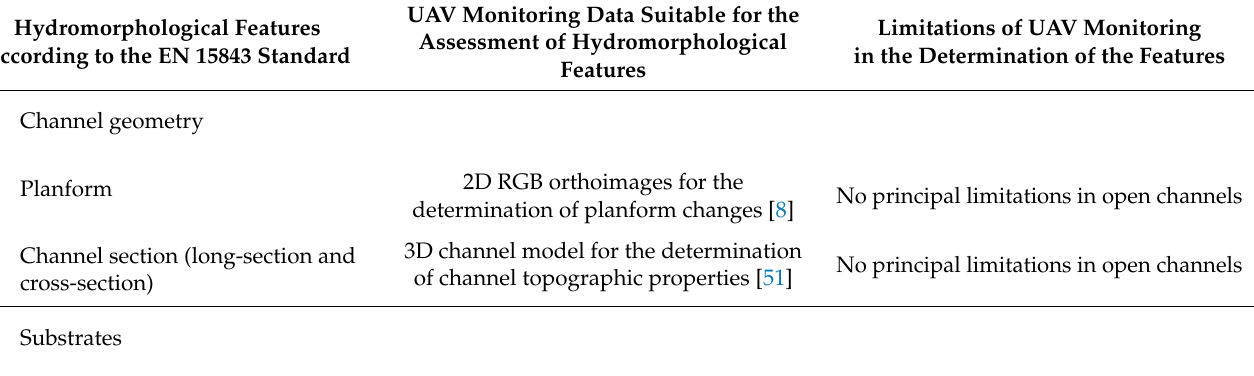
Table 2. Suitability of hydromorphological features for UAV